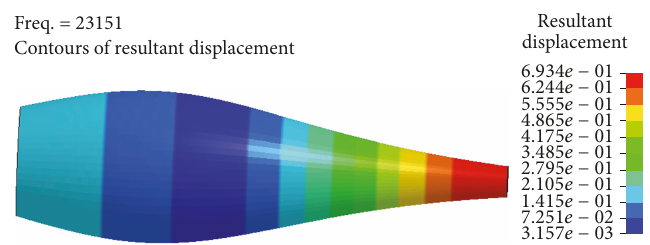
Figure 9: The mode shape for the natural frequency of 𝑓 = 23 , 151 Hz.